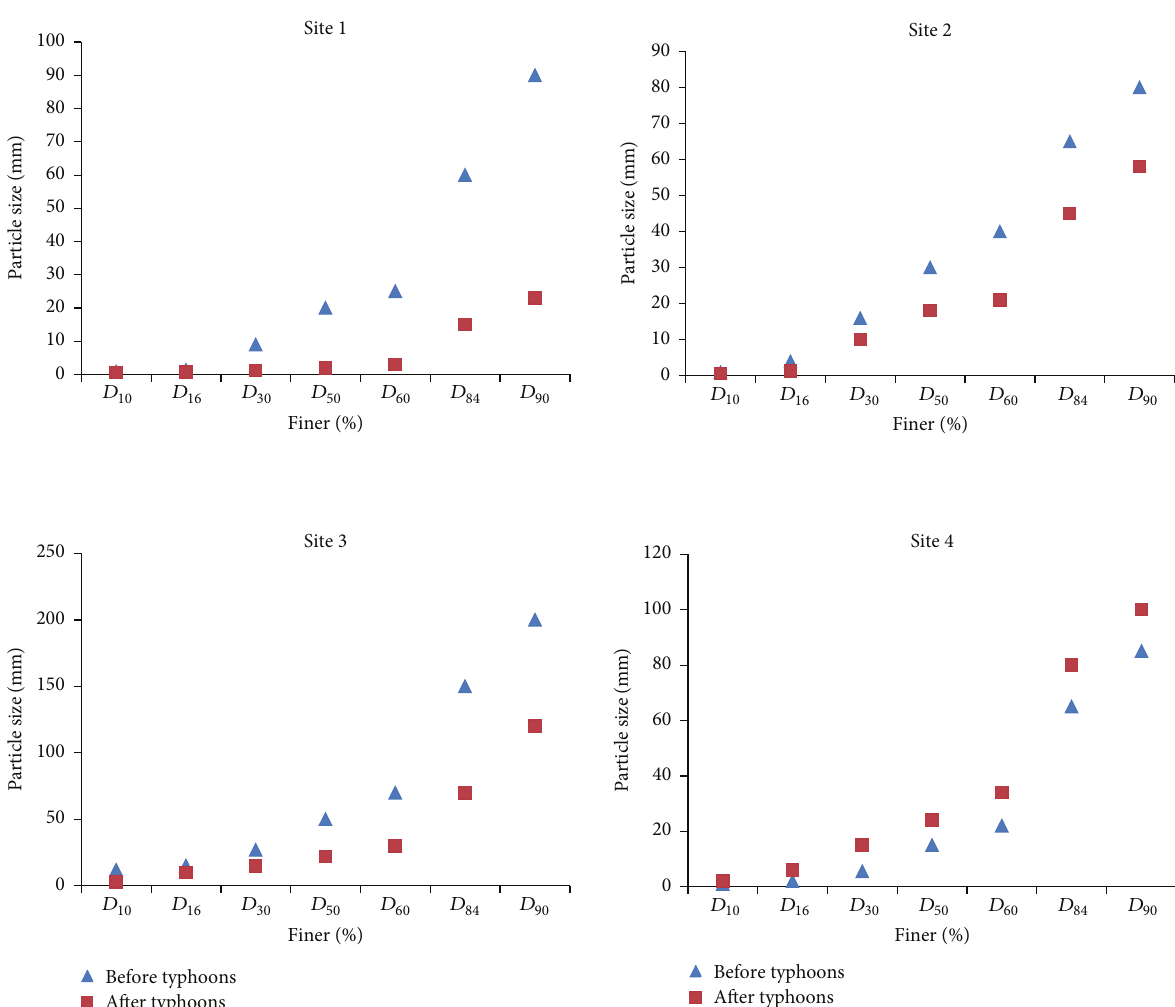
Figure 4: Grain size distribution before and after typhoon season using the volumetric method.